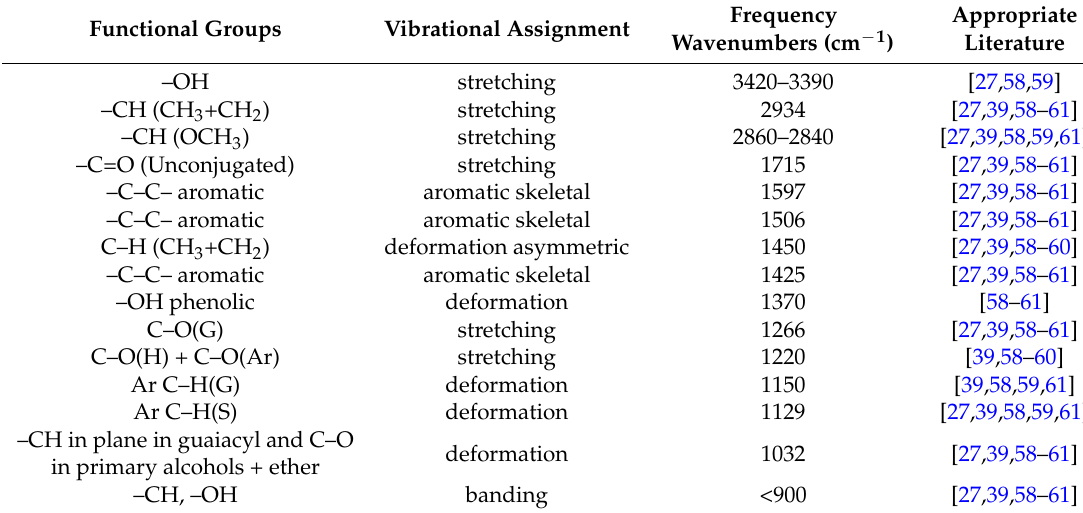
Table 1. Vibrational wavenumbers (cm − 1 ) for kraft lignin